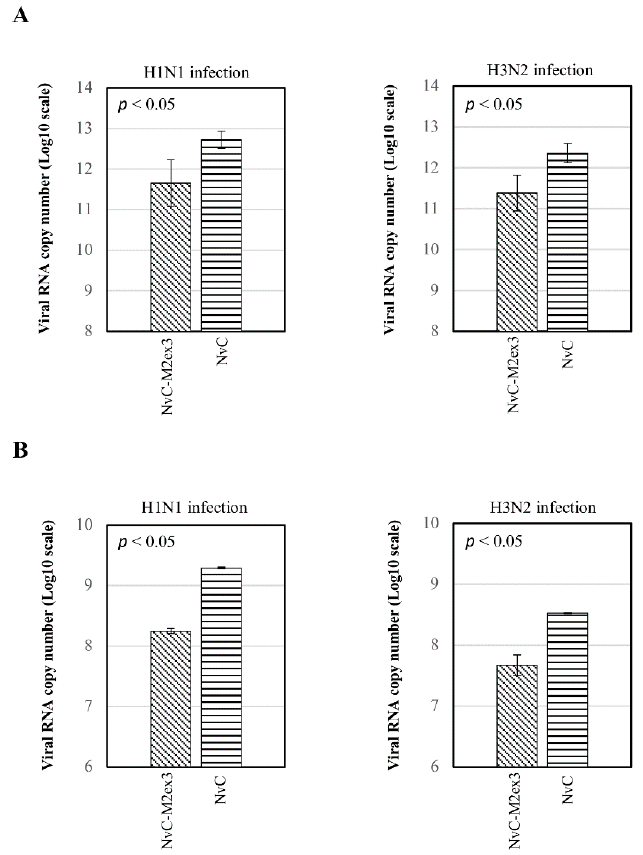
Figure 3. Viral RNA copy numbers in the lungs and oropharynges of infected mice. At day five post-infection, the lungs and oropharyngeal swabs of the infected mice (n = 3) were obtained. The viral RNA was then extracted, reverse transcribed, and quantified using quantitative polymerase chain reaction (qPCR). ( A ) Higher viral RNA copy numbers (10-fold) were detected in the lungs of the mice immunized with NvC relative to those immunized with NvC-M2ex3 after being challenged with H1N1 or H3N2. These results demonstrate the potential of NvC-M2ex3 in limiting virus replication. ( B ) Detection of the viral RNA of H1N1 or H3N2 in the oropharynges of the mice suggests viral shedding and possible transmission between animals. All the NvC-M2ex3-immunized mice exhibited a reduced viral shedding in both lethal H1N1 and H3N2 infections. The di ff erences between treatment groups are significant with p <